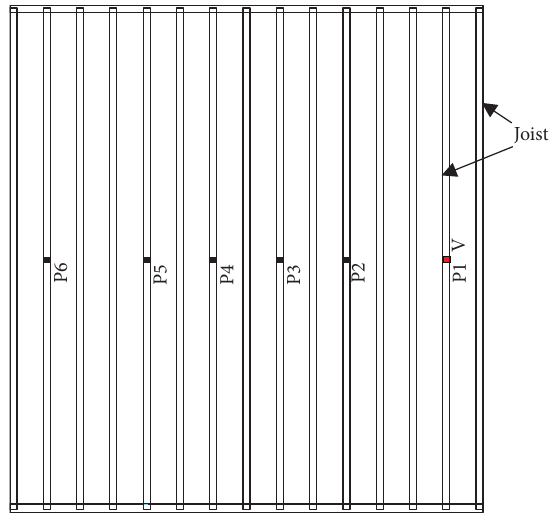
Figure 5: Locations of the hammer impact excitation and response